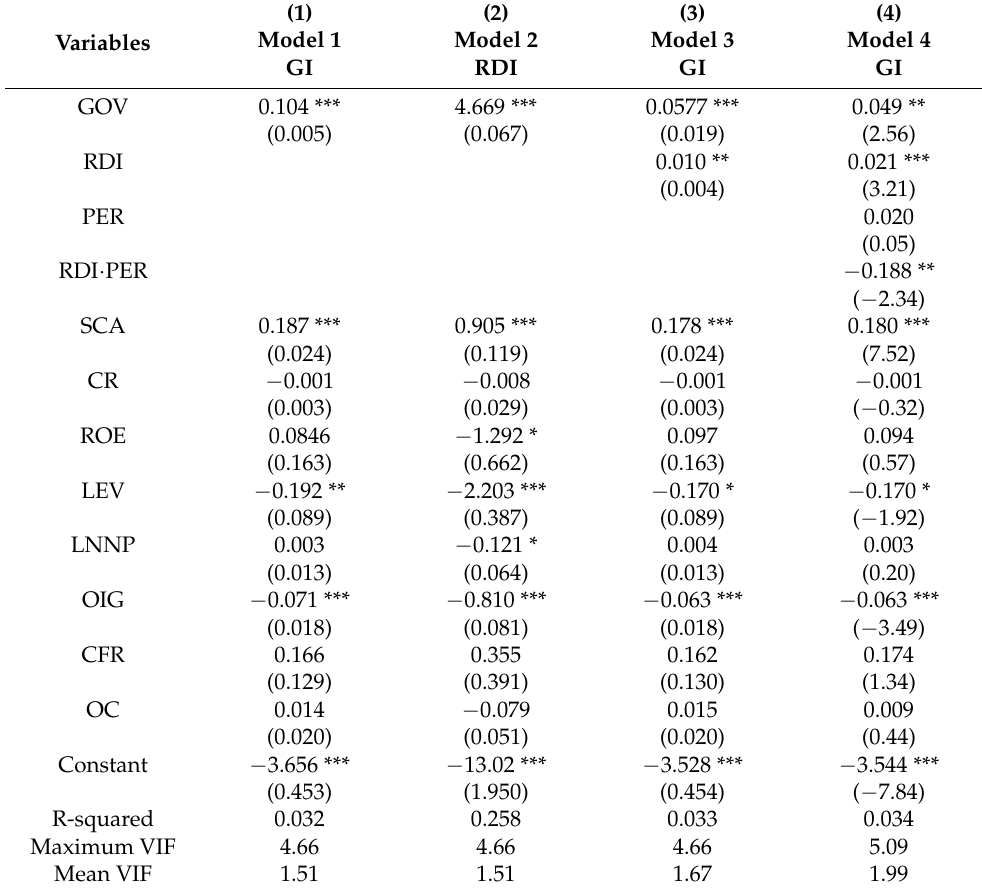
Table 3. Regression results in direct, mediating and moderating